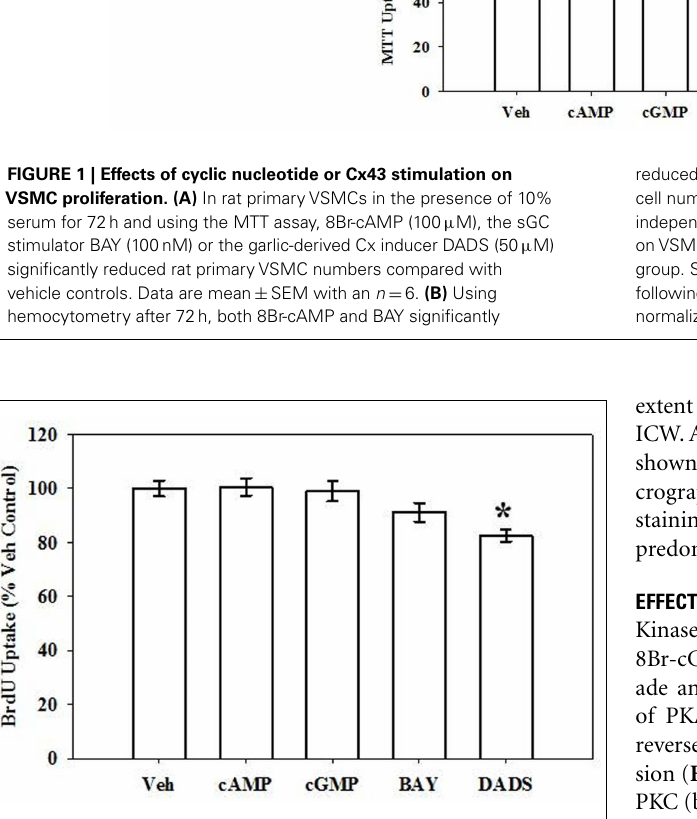
FIGURE 2 | Effects of cyclic nucleotide or Cx43 stimulation onVSMC DNA synthesis. In rat primaryVSMCs in the presence of 10% serum for 6h, DADS (50 µ M) significantly reduced the rate of DNA synthesis by 20% compared with vehicle controls estimated by BrdU incorporation. Data are mean ± SE from three independent experiments each with an n = 6. Student–Newman–Keuls method for multiple comparisons following one-way ANOVA was used. * p < 0.05compared with normalized vehicle